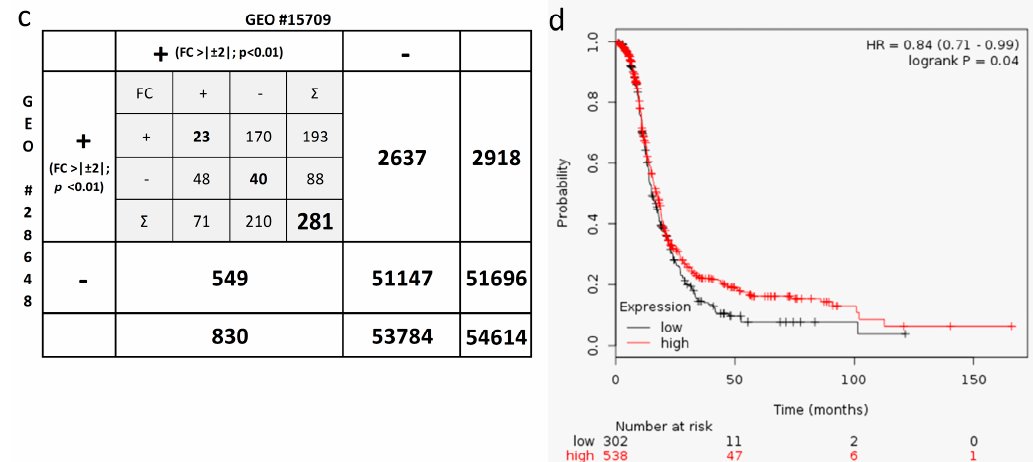
Figure 5. Cisplatin resistance in A2780 can be associated with different genome wide gene expression profiles. ( a , b ) Volcano plots for transcripts differentially expressed between parental A2780 and cisplatin-resistant A2780 ( p < 0.01 and fold change (FC) >2 or < − 2) from either GEO#15709 ( a ) or GEO#28648 ( b ). Color codes relate to data from GEO#28648 depicting upregulated genes (green), down regulated genes (red) or genes not differentially expressed in this dataset, but in GEO#15709 (grey). The comparison of both plots indicates largely different genome wide expression changes during resistance development in the two independent resistant A2780 cell cultures (GEO#15709; GEO#28648); ( c ) Cross table comparing the number of targets which are differentially expressed or unchanged in both data sets (outer table). Whereas most genes were not affected in both sets (93.7%) only 281 targets from 2918 (GEO#28648) or from 830 (GEO#15709) are concordantly deregulated. Moreover, only 63 from these 281 transcripts are deregulated in the same direction (23 upregulated, 40 down regulated; inner table, grey). The expression of the majority of 218/281 transcripts is changed in opposite directions; ( d ) Prognostic value of RUNX3 gene expression analyzed by the Kaplan–Meier-Plotter for public available datasets from EOC patients (serous, FIGO III/IV, treated with platinum; n = 840). Patients with high RUNX3 gene expression show slightly increased progression free survival (PFS) compared to the RUNX3 -low group.